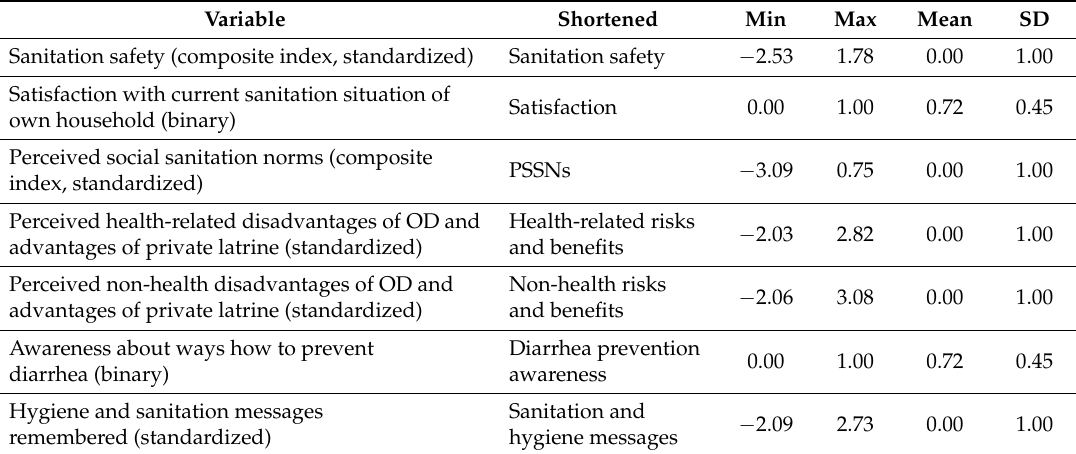
Table 2. Main variables of interest and their basic descriptive statistics ( N =